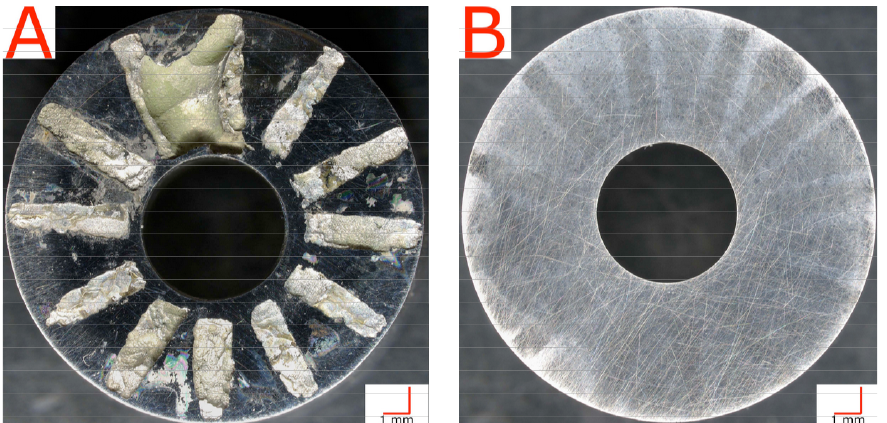
Figure 7. Plan-view light-optical images after CCT testing at 358K. ( A ) AM-SRA-X sample with massive crevice-corrosion failure. ( B ) AM-SRH-LTNC sample showing no indication of crevice corrosion at the maximum testing temperature.